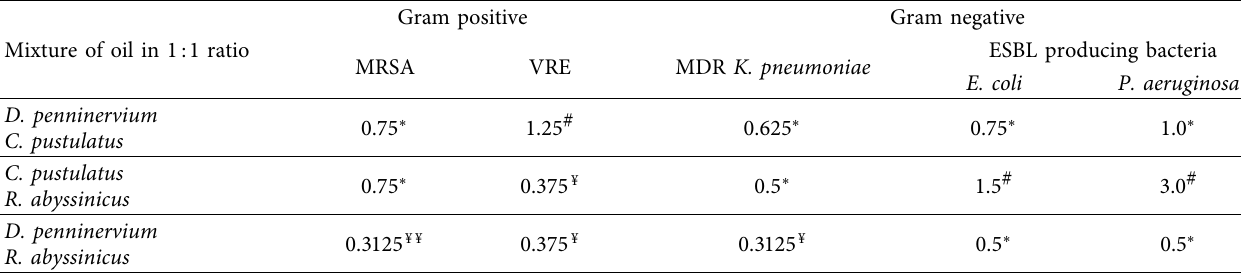
Table 5: The mean fractional inhibitory concentration index for MDR bacteria at KMU, 2020. Mixture of oil in 1 :1